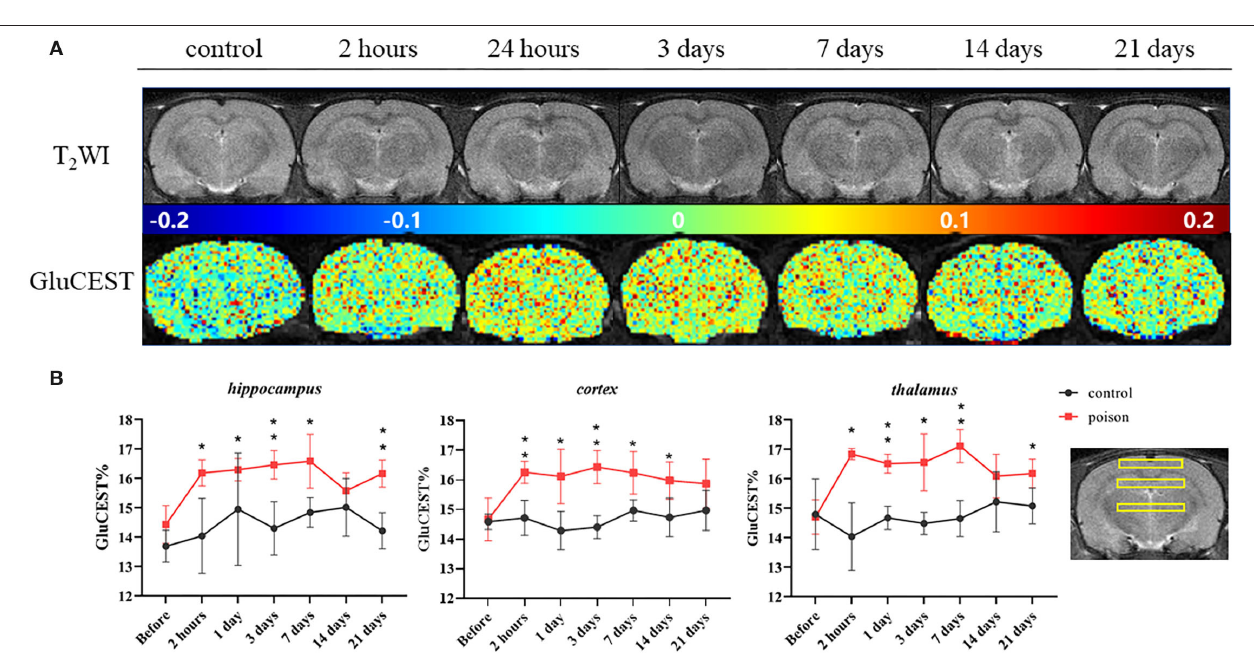
thickness without a gap. Then we obtained the three-dimensional T2-weighted images (T 2 WI) using a fast spin echo sequence with the following parameters: repetition time = 3,000 ms, FOV = 35 mm × 35 mm, 2562 × 56 matrix, 2.0 mm thickness, and 0.2 mm